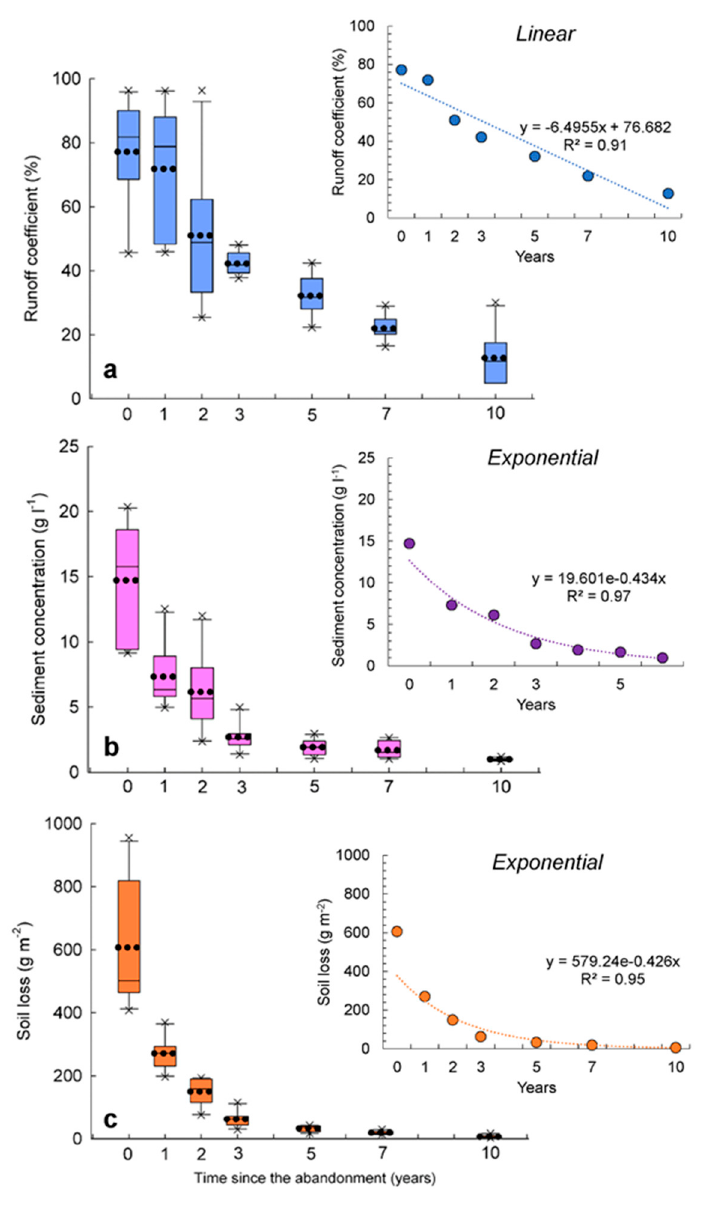
Figure 4. Evolution of the runoff coefficient, sediment concentration, and soil loss along the abandonment time from active plantations to 10-years old abandonment. Dotted line: average ( n = 10). ( a ) Runoff coefficient; ( b ) Sediment concentration; ( c ) Soil loss. Table 2. Spearman rank coefficient between environmental factors, hydrological responses, and soil erosion. SM: antecedent soil moisture; BD: bulk density; OM: organic matter; Plants: plant cover; Rock: rock fragment cover; Crust: soil crust; Tp: time to ponding; Tr: time to runoff generation; Tro: time to runoff in outlet; Rc: runoff coefficient; SC: sediment concentration; SL: soil loss.